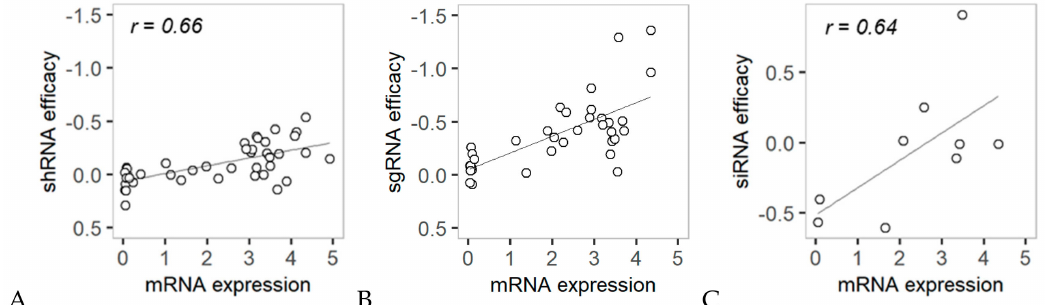
Figure 6. Comparison of HNF1B mRNA expression vs. RNAi e ffi cacy in di ff erent colon cancer cell lines. ( A , B ) HNF1B mRNA expression vs. shHNF1B / sgHNF1B e ffi cacy in 42 / 35 colon cancer cell lines. ( C ) Experimental validation of HNF1B mRNA expression and siHNF1B e ffi cacy in nine colon cancer cell